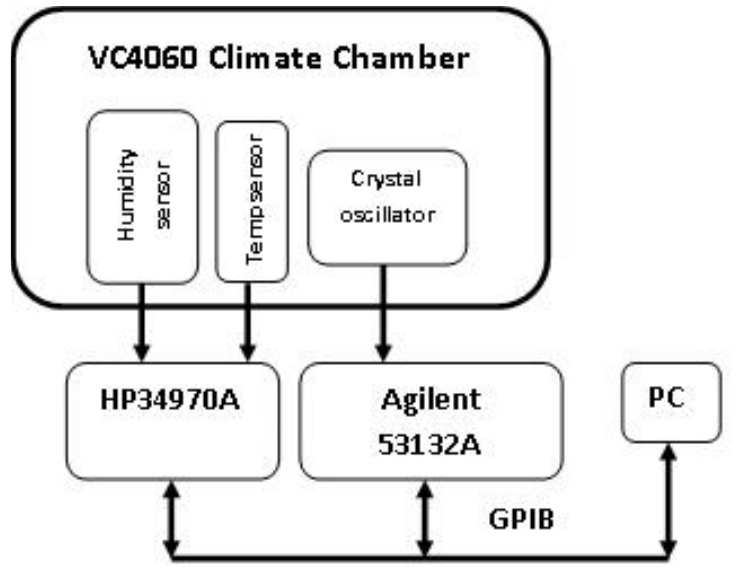
Figure 21. Measurement system block